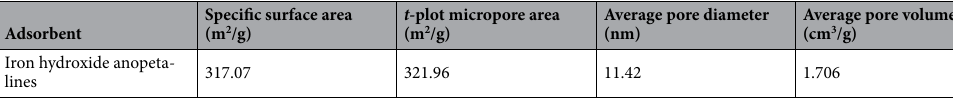
Table 1. BET specific surface area and porosity measurements of the